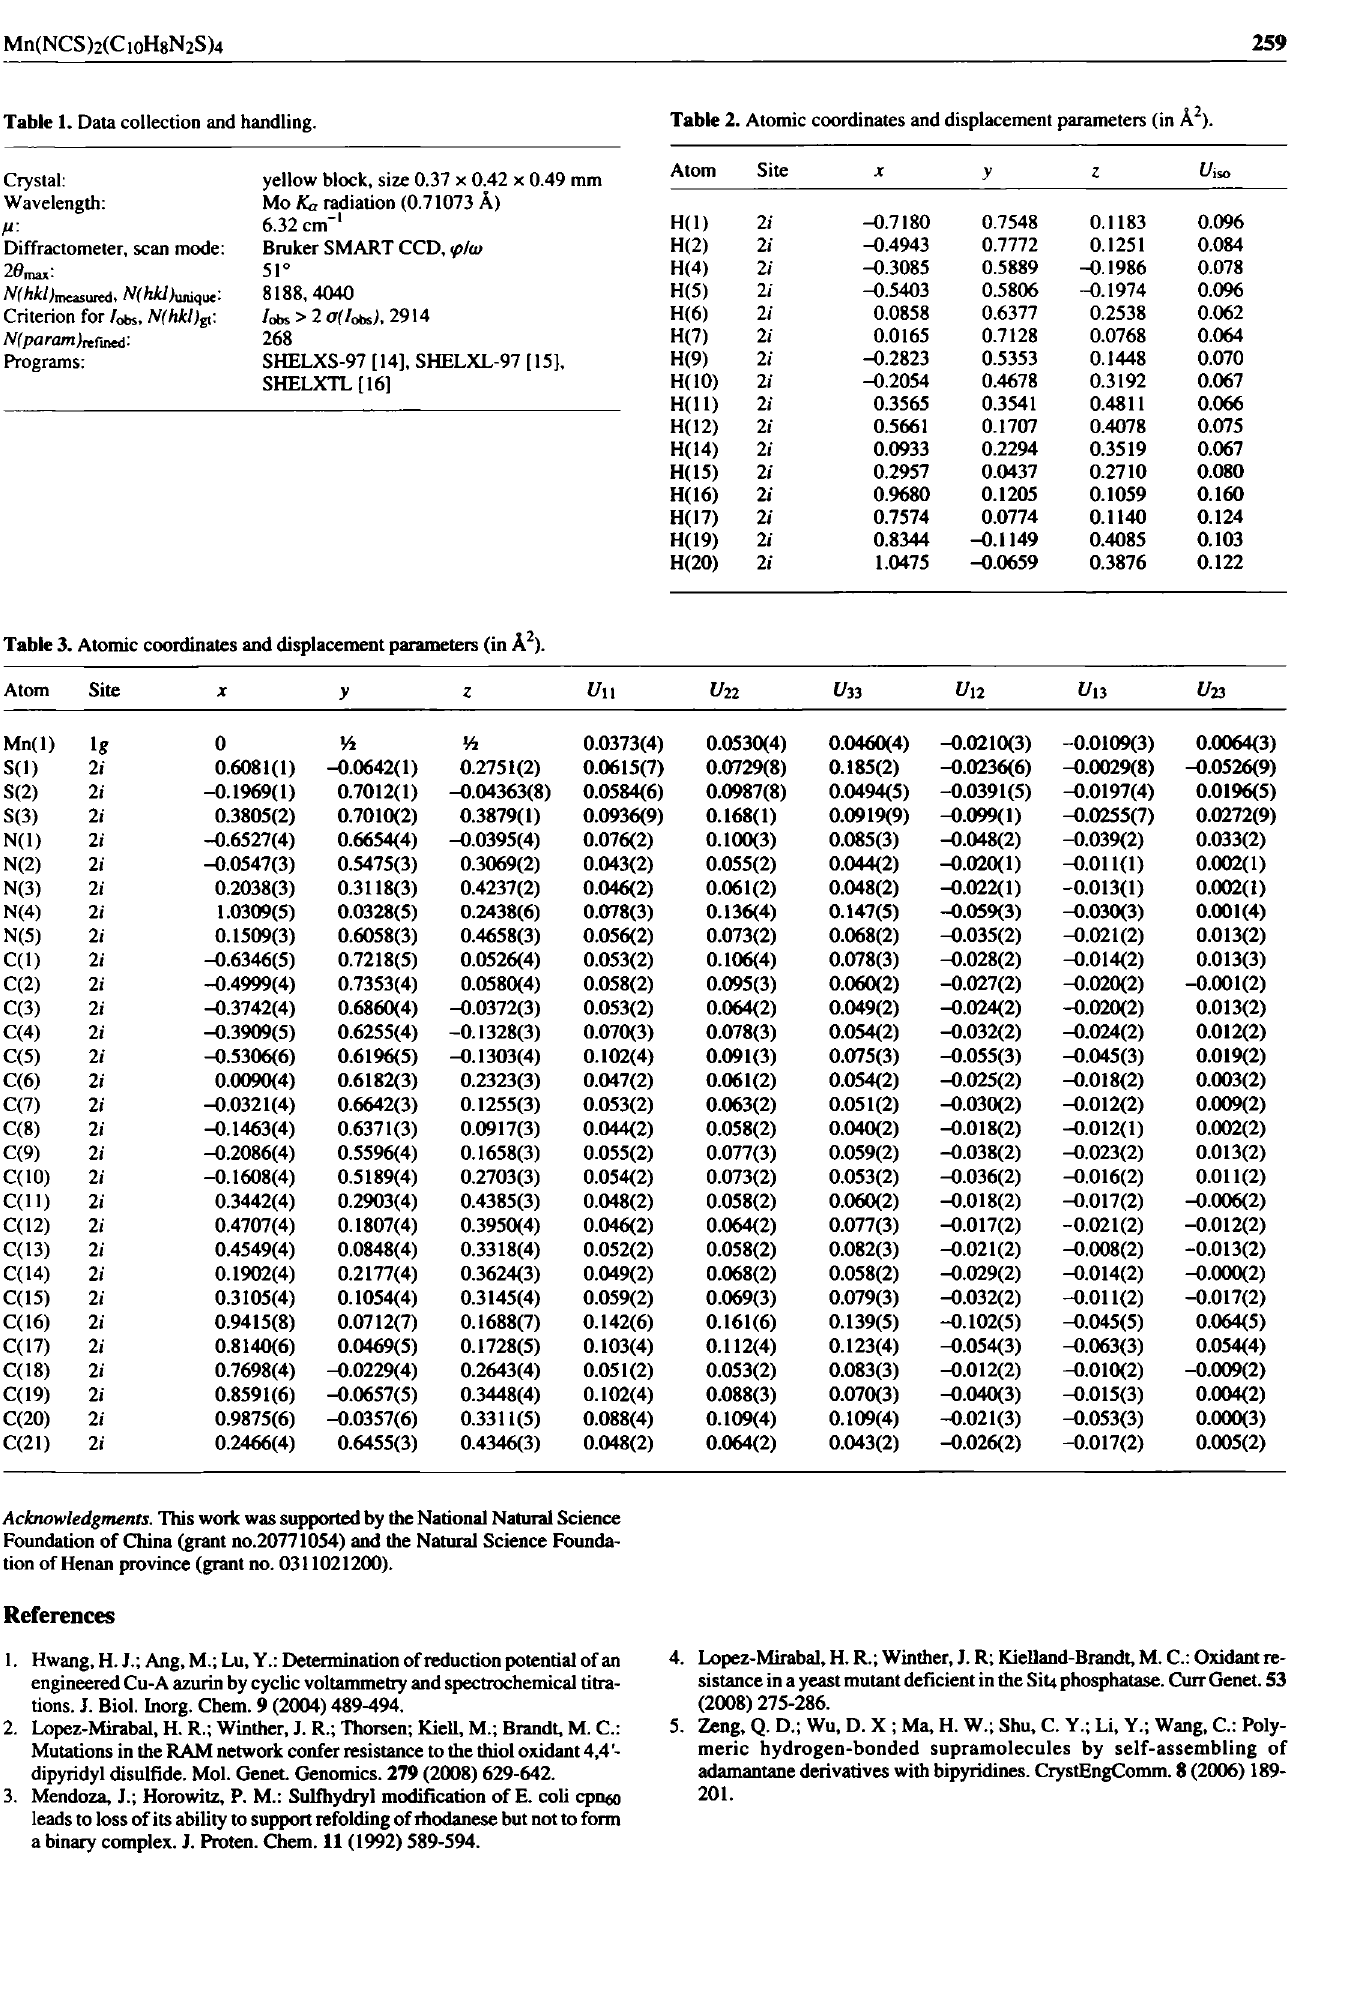
Table 1. Data collection and handling. Table 2. Atomic coordinates and displacement parameters (in Ä 2 ).